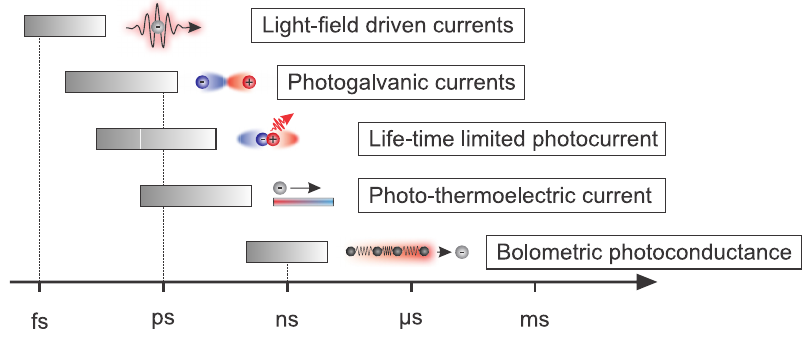
Figure 1: Time scales of ultrafast light-driven currents in low-dimensional van der Waals